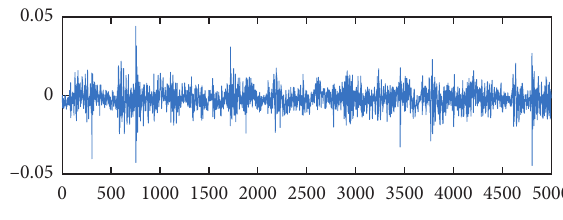
Figure 24: A ball fault vibration signal sample.